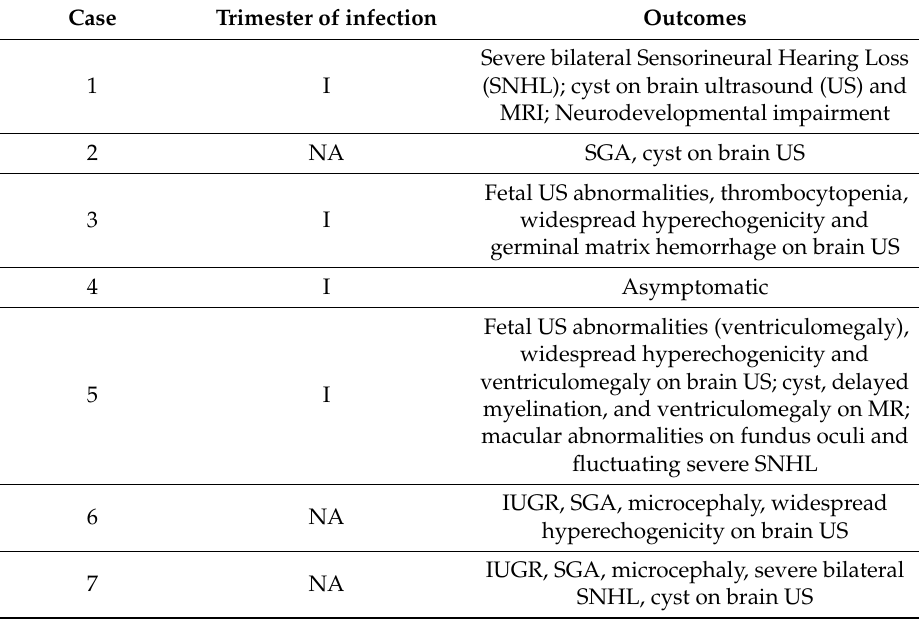
Table 6. Non primary